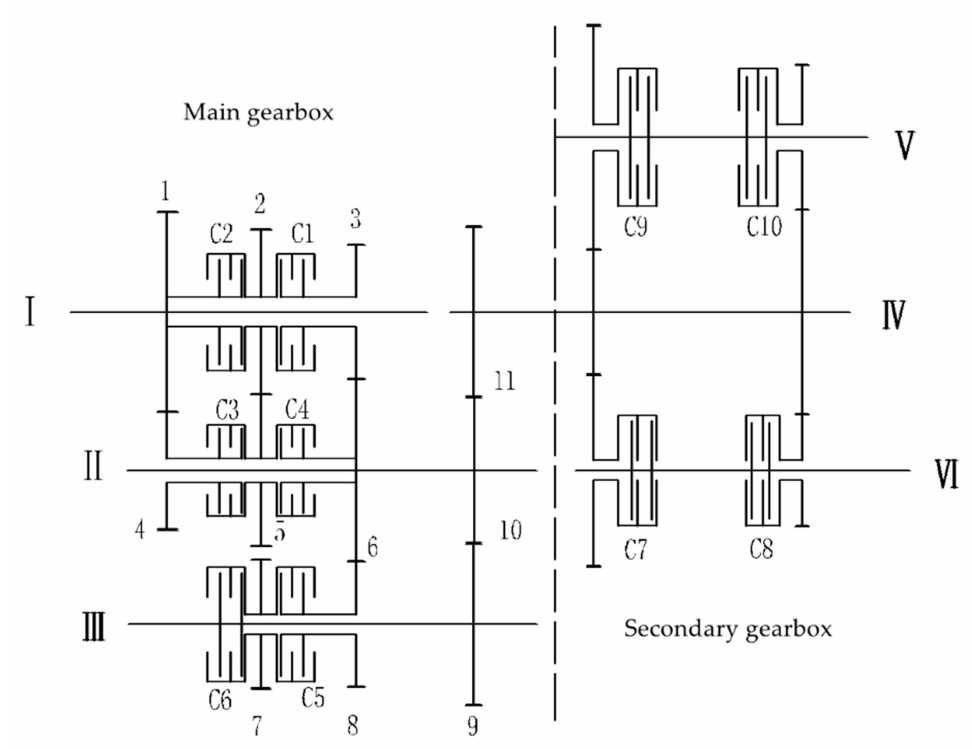
Figure 1. Full power shift transmission (partial) power transmission scheme.